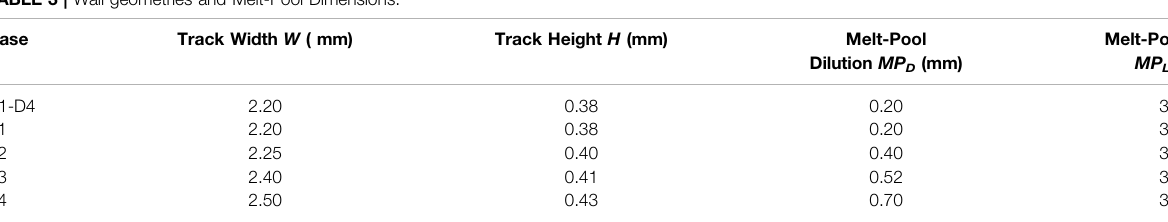
TABLE 3 | Wall geometries and Melt-Pool Dimensions.